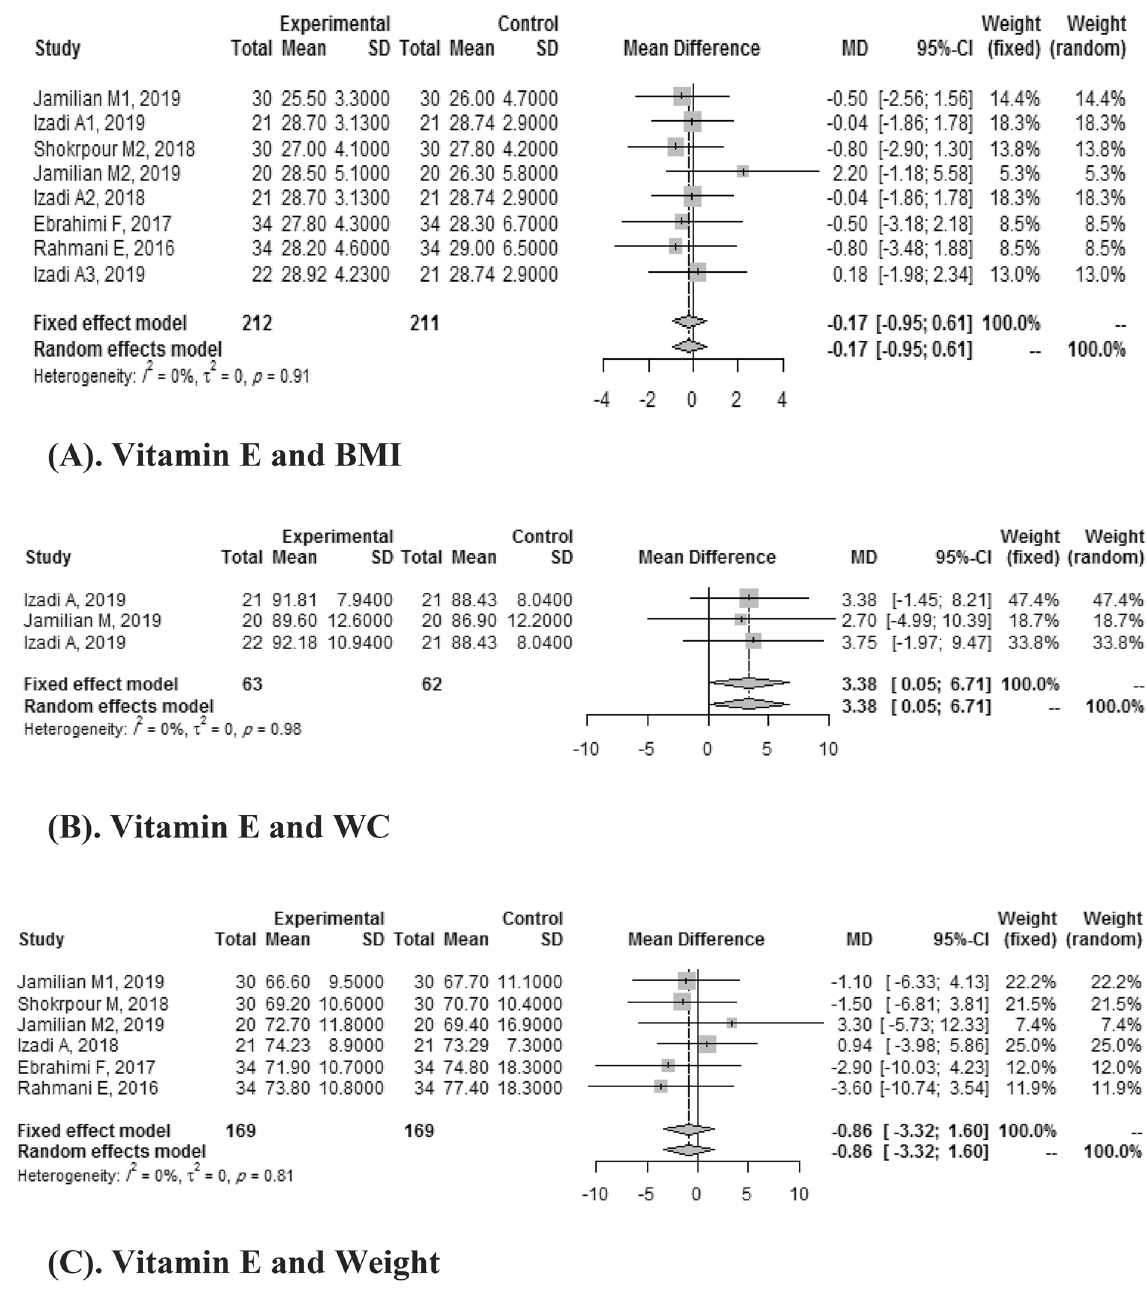
Figure 3. ( A ) Vitamin E and BMI. ( B ) Vitamin E and WC. ( C ) Vitamin E and